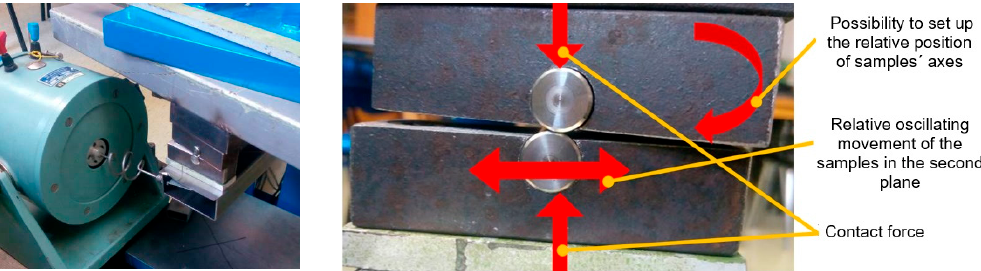
Figure 22. Frequency tribological testing device: Detail of adjustable holders and vibration exciter; ( left ), detail of samples positioning with the indication of movement possibilities ( right ).